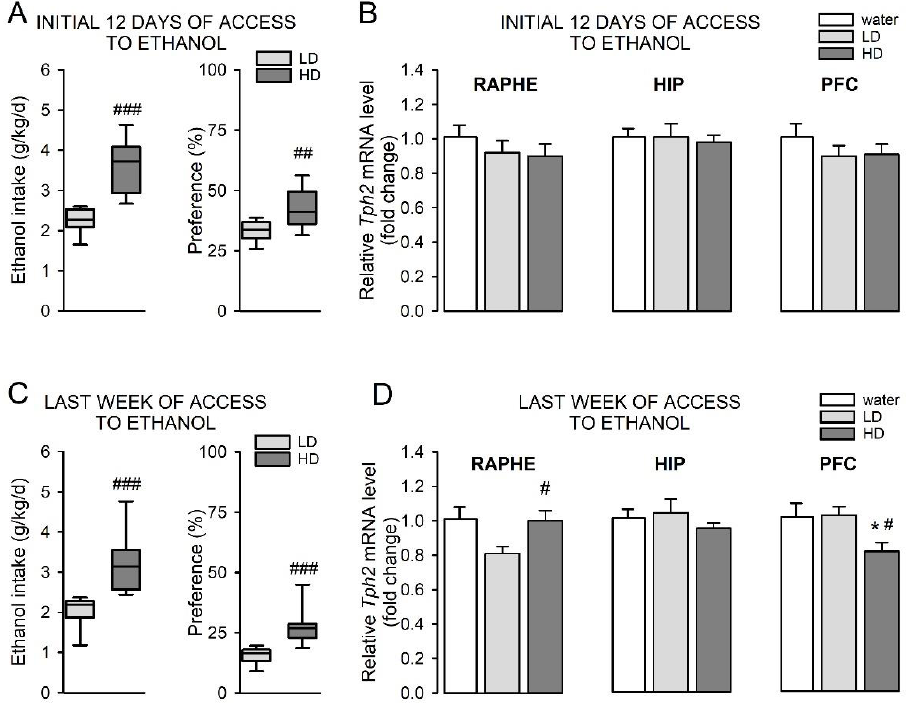
Figure 4. Transcript level of Tph2 in the brain of “high ethanol-drinking” and “low ethanol-drinking” mice over different experimental periods. Tph2 +/+ mice were exposed to increasing concentrations of ethanol (3–10%) for 29 days. Animals that were given access to two bottles of water were used as controls. On the last day of ethanol drinking, mice were introduced to the FST and, after the test, they were immediately killed by decapitation. The Tph2 transcript level was analyzed in the raphe nuclei (RAPHE), hippocampus (HIP), and prefrontal cortex (PFC) by RT-qPCR. For each investigated period—( A , B ) an initial 12 days of access to ethanol and ( C , D ) the last week of access to ethanol—mice were divided into “high ethanol-drinking” (HD) and “low ethanol-drinking” (LD) mice based on individual differences in the average ethanol intake levels. For each analyzed period, average ethanol intake (g/kg/d) and average preference for ethanol (%) were calculated for HD and LD groups ( A , C ). The Tph2 transcript levels were then compared between HD and LD mice ( B , D ). As a control, the Tph2 mRNA level for mice drinking water was used. ( A , C ): Data are shown as box plots, in which the horizontal line depicts the median, and vertical boxes and whiskers correspond to the percentile range. n = 8–9 mice/group. ( B , D ): All RT-qPCR data were normalized to a housekeeping gene, TATA box binding protein ( Tbp ), and represent fold change (2 − ∆∆ C T ) means of data from 5–9 mice/group. ( A ): t -test: ## p < 0.01, ### p < 0.001 vs. LD. ( C ): Mann–Whitney U test: ### p <